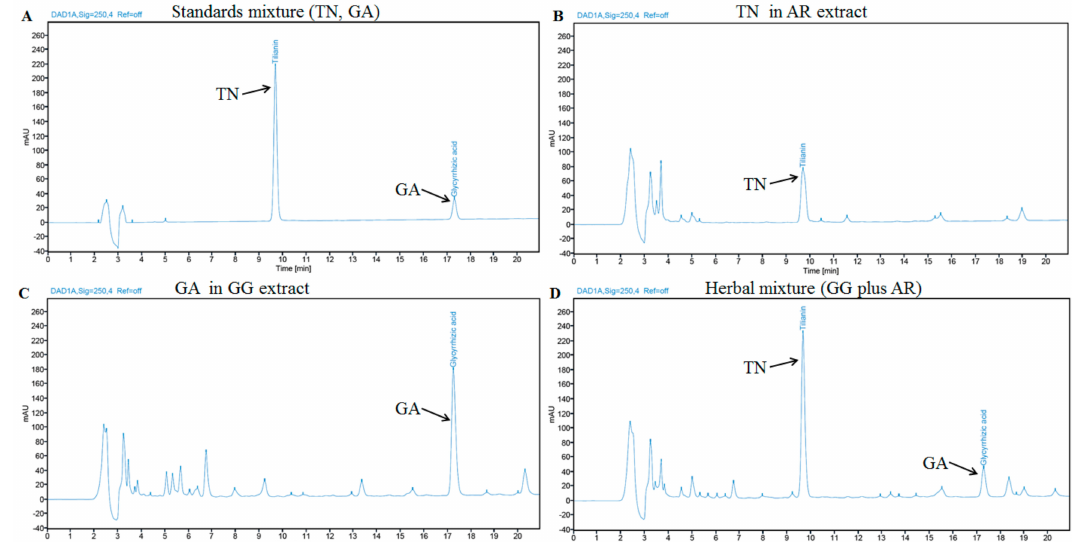
Figure 9. HPLC chromatogram of two standards mixture ( A ), AR extract ( B ), GG extract ( C ), and their mixture ( D ) at 250 nm. TN and GA were appeared at a retention time of approximately 9.67 and 17.28 min,